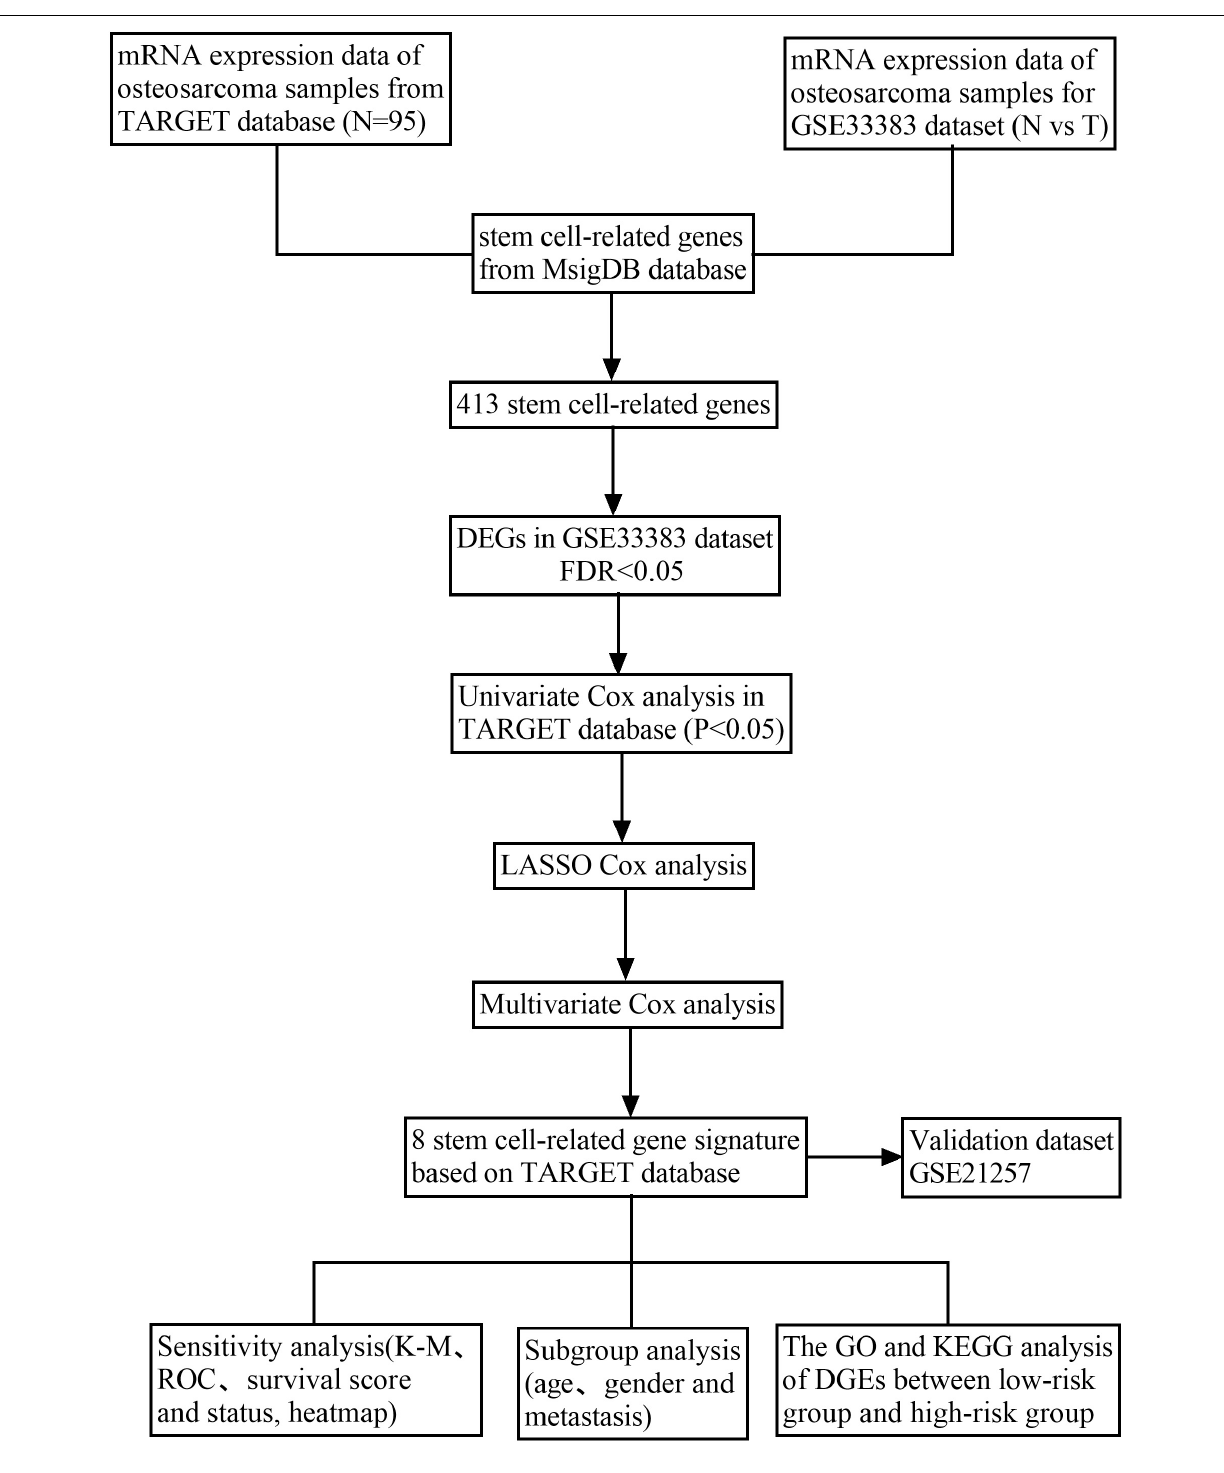
FIGURE 1 | Flow chart of data gathering and analysis.